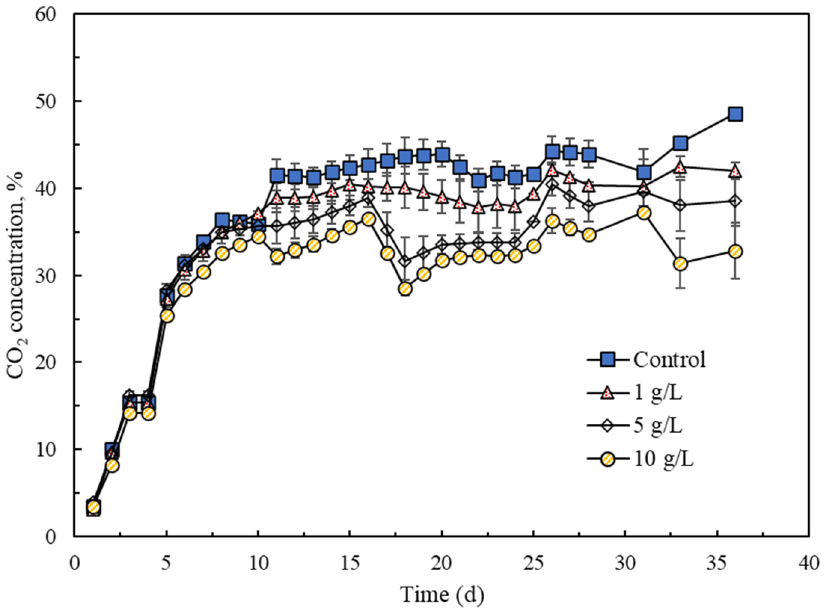
Figure 4. Change of CO 2 concentration during AD of dairy manure with the addition of different concentrations of AF-BC. concentrations of